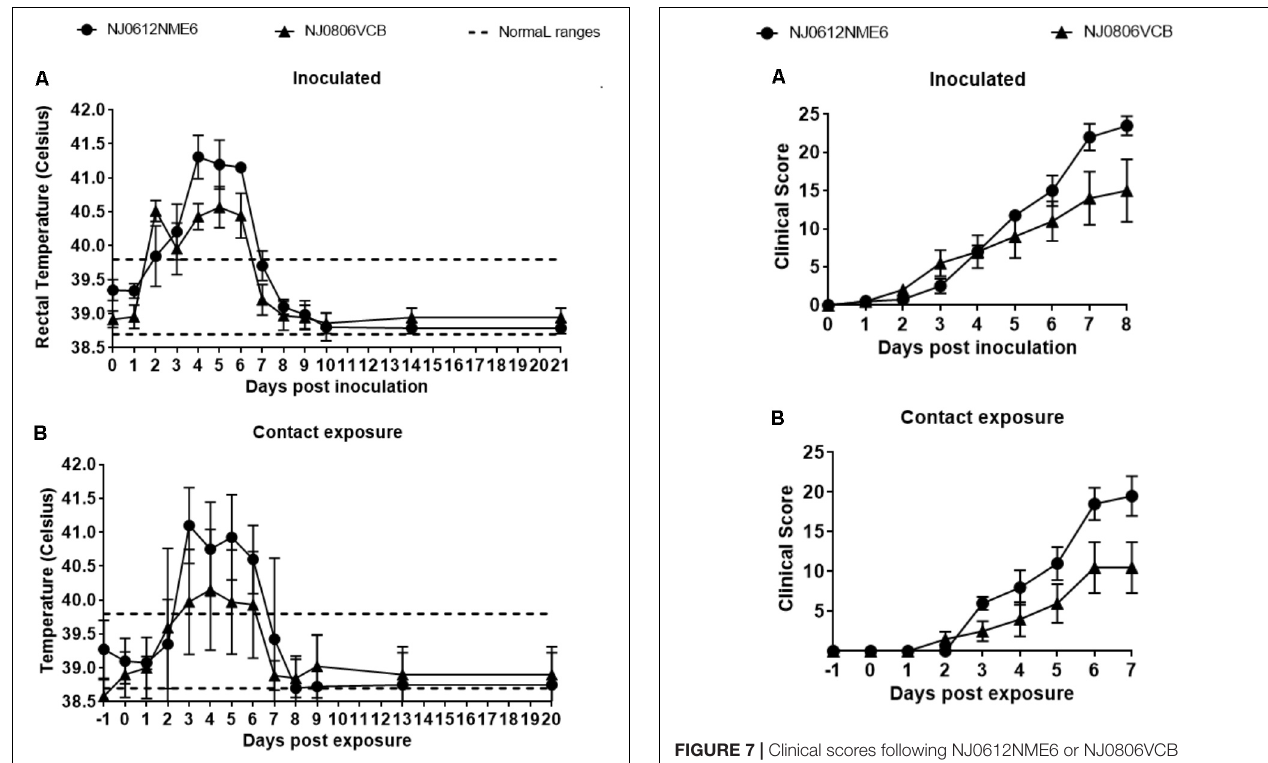
FIGURE 6 | Fever response following NJ0612NME6 or NJ0806VCB inoculation. Two independent groups of four pigs were inoculated with 1 × 10 7 TCID 50 and then allowed to co-mingle with four contact pigs at 24 hpi. The rectal temperature of (A) inoculated and (B) contact exposure pigs is shown along with a dashed line which represents the standard rectal temperature of an uninfected pig. In all cases values represent means and standard deviations for each group of pigs.